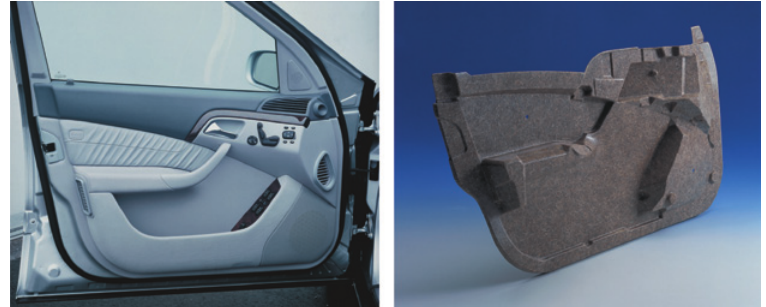
Figure 4: These modern door inner trim panels are molded using mats of 60% natural fiber in a Baypreg polyurethane resin (Courtesy of Bayer Polymers)